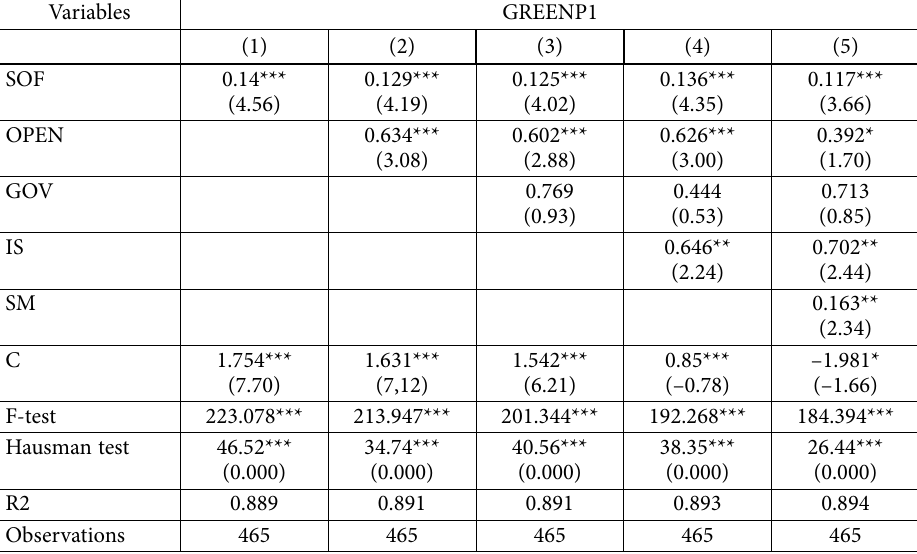
Table 2. The result of baseline